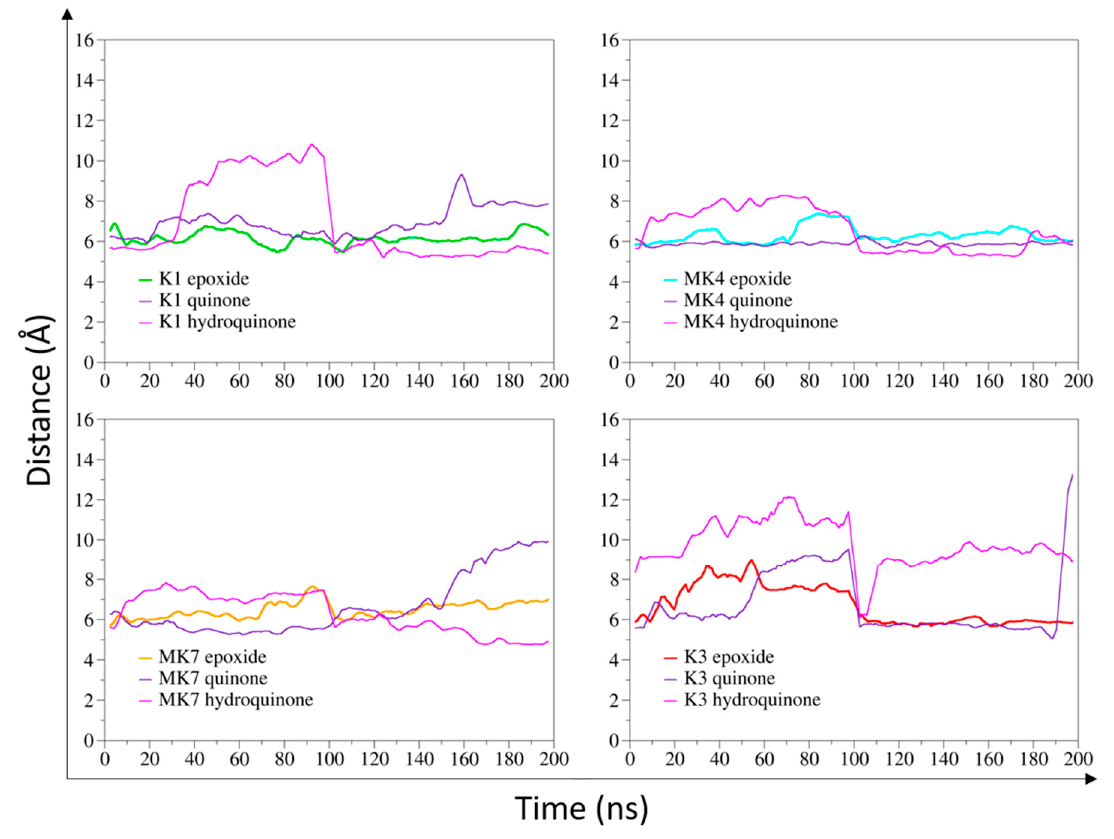
Figure 1. Distance measurement between the carbon-2 atom of vitamin K (K1, MK4, MK7 and K3 in their epoxide, quinone, and hydroquinone states) and the vitamin K epoxide reductase (VKORC1) catalytic site ( α -carbon of the C135 residue) in molecular dynamics (MD) simulations. The epoxide states of vitamins K1, MK4, MK7, and K3 are shown as green, cyan, orange, and red lines, respectively. The quinone state is depicted as a violet line and hydroquinone as a pink line, for each form of vitamin K. Two 100-ns MD simulations were performed for each vitamin K–VKORC1 complex, then concatenated to be considered as one 200-ns MD simulation.